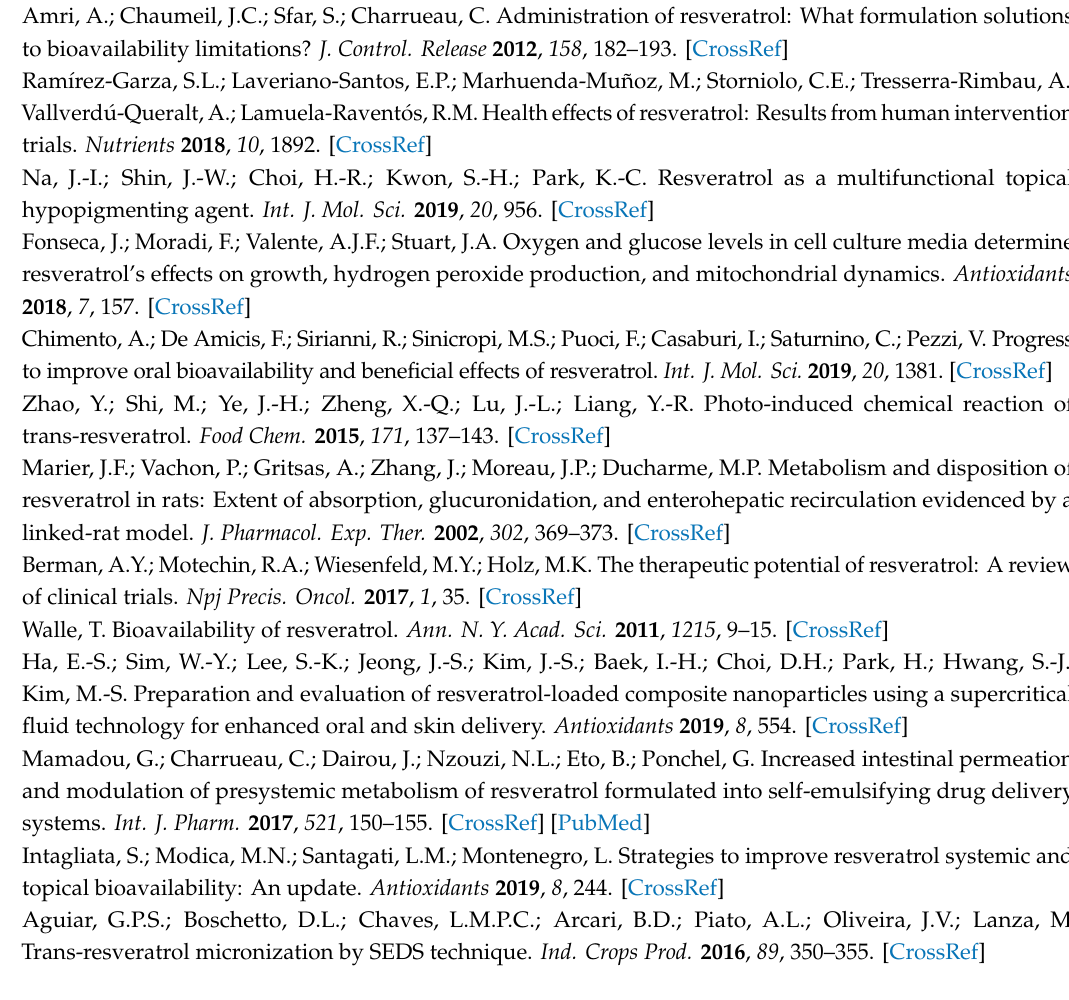
Table S1: DSC data of raw material, SAS processed nanoarticles and milled microparticles consisted of pure